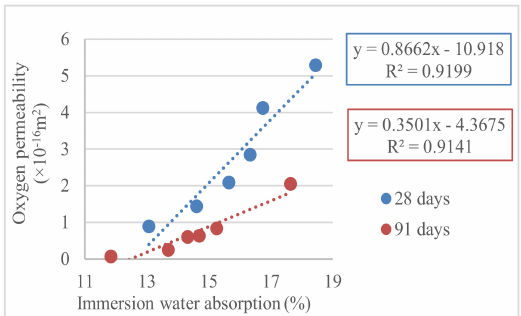
Figure 9. Relationship between oxygen permeability and immersion water absorption results at 28 and 91 days.